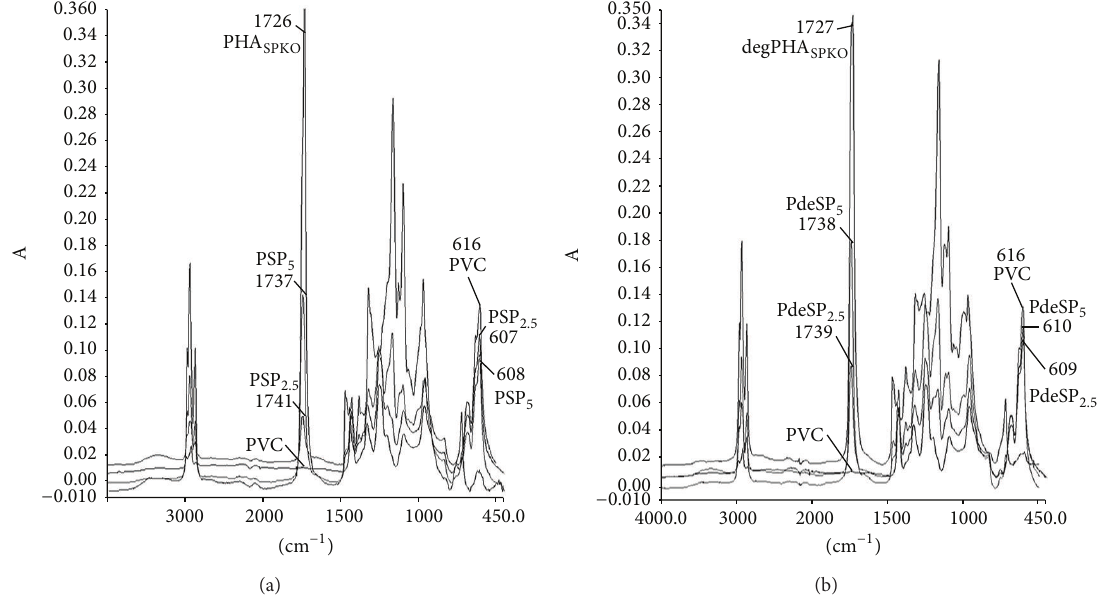
Figure 2: ATR-FTIR absorption spectra of (a) PVC, PHA SPKO , and PSP and (b) PVC, degPHA SPKO , and